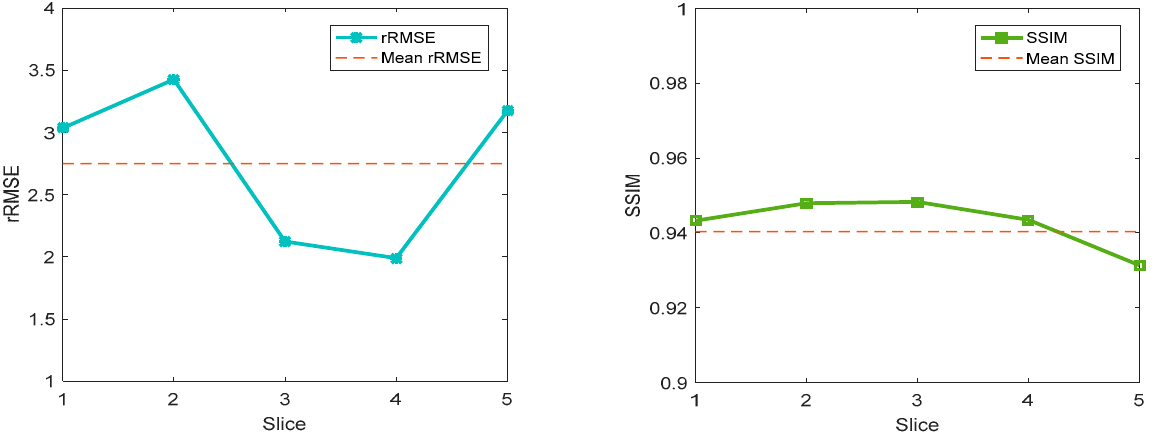
Figure 14. Reconstruction results of five selected images of human brain dataset: 1–59 depicts the